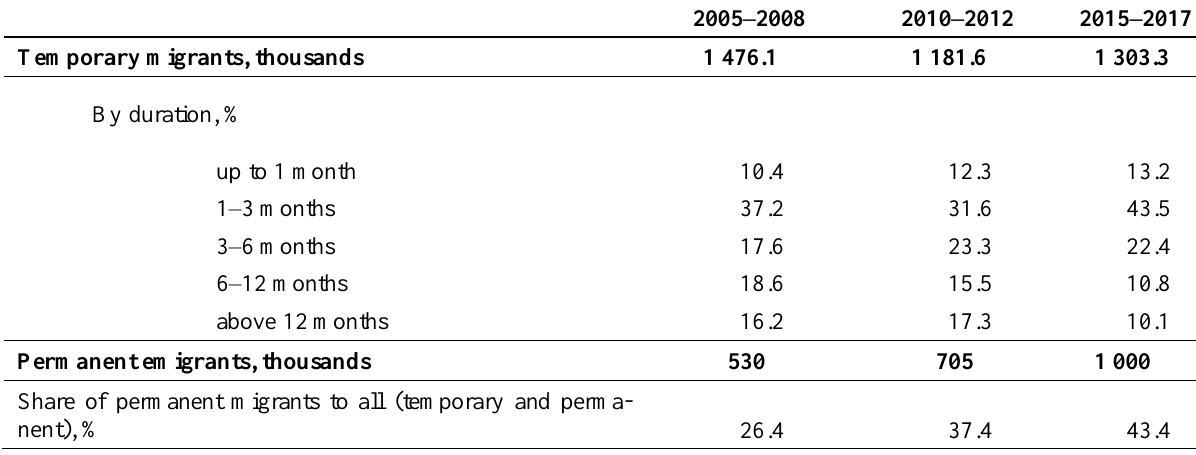
Table 2. Ukrainian labour emigrants by duration of